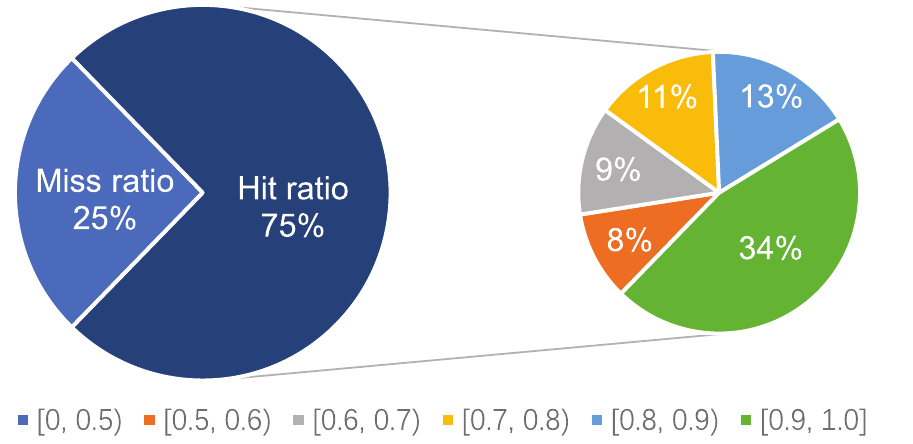
Fig 4. Results on the independent test set. Hit ratio denotes the percentage of links in the set that are identified by GripDL. The right pie presents the percentages of hits with different output ranges.